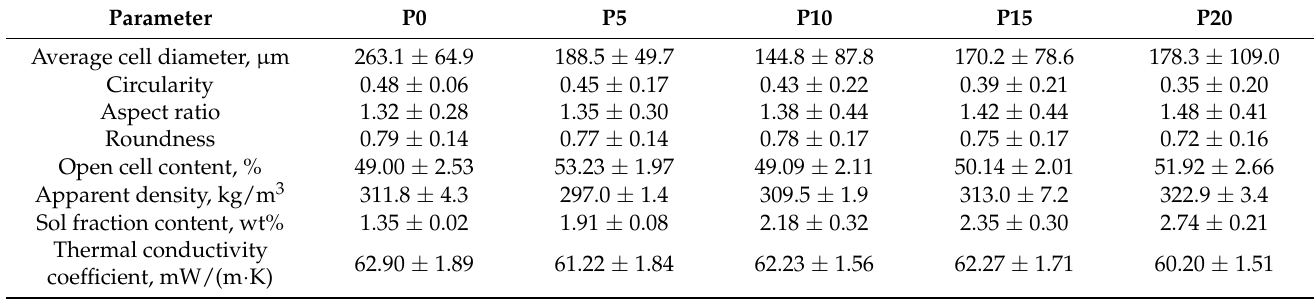
Table 4. Parameters describing cellular structure and thermal insulation performance of prepared foamed PU/GTR composites.